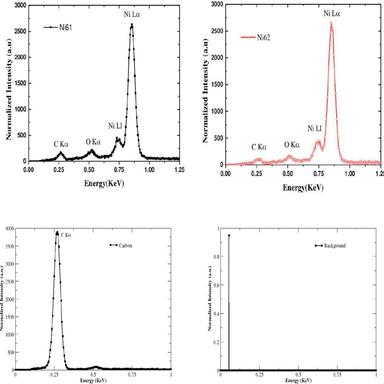
The energy spectrum of 61Ni, 62Ni, carbon and empty background (in order) with the energy channel along the x-axis and the counts of event along the y-axis.